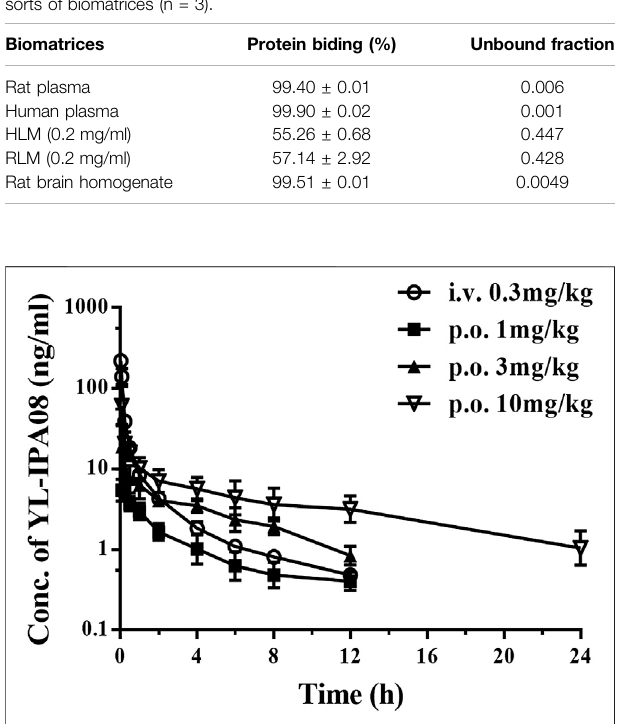
FIGURE 3 | Plasma concentration-time pro fi les of YL-IPA08 after intravenous (0.3 mg/kg) and oral administration of different doses (1, 3, 10 mg/kg) of YL-IPA08 in rats. Error bars represent the standard deviation of the mean concentration (n (cid:2)